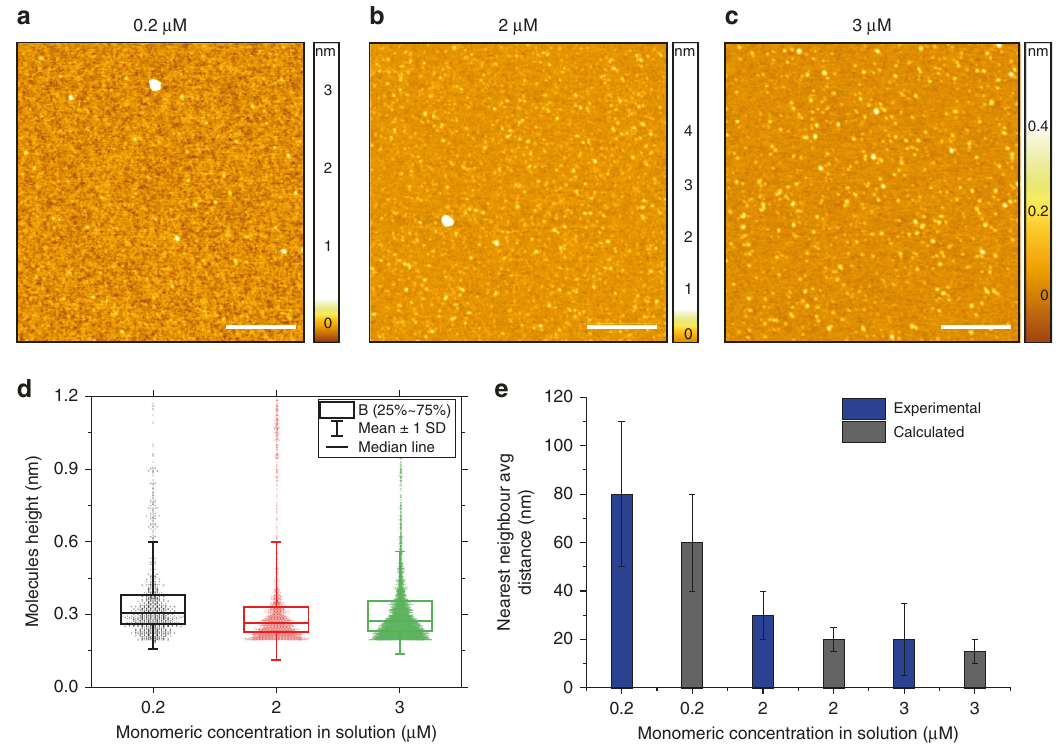
Fig. 4 Micro fl uidic spray deposition avoids arti fi cial self-assembly and enables accurate tuning of molecules concentration on the surface. AFM maps of the micro fl uidic spray deposition of a monomeric solution of α -synuclein at ( a ) 0.2 μ M, ( b ) 2 μ M, and ( c ) 3 μ M for 5 s at 100 μ l h − 1 (scale bars 200 nm). d Box chart distributions of the cross-sectional height of the deposited biomolecules is independent from the concentration of deposition ( n = 1003 0.2 μ M, n = 2441 for 0.5 μ M, n = 3685 for 3 μ M; the horizontal line represents the median, the box the fi rst to third interquartile, and the error is the s.d.). e Average molecular distance on the surface (average nearest neighbor) decreases as a function of the concentration of the deposited solution, in excellent agreement with theoretical calculations (values are mean ±